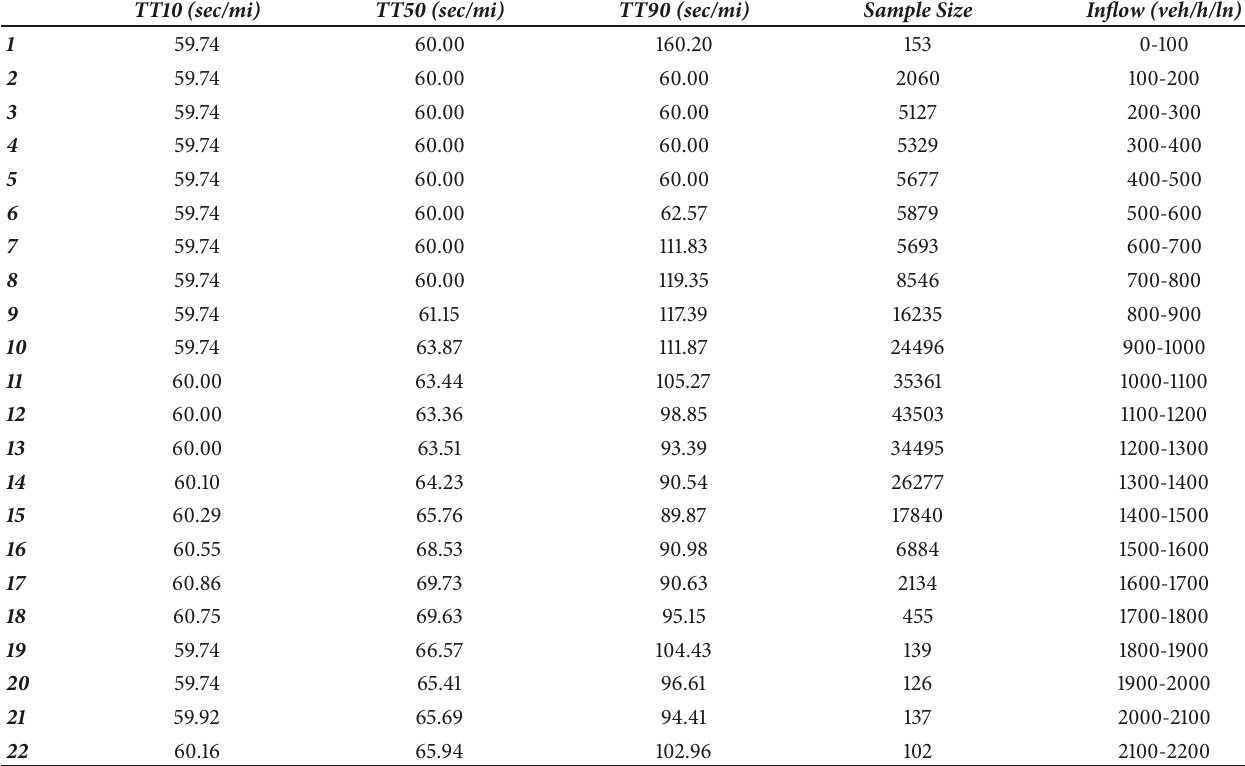
Table 1: Table of inflow-percentile travel time of GPL I-405 South under normal